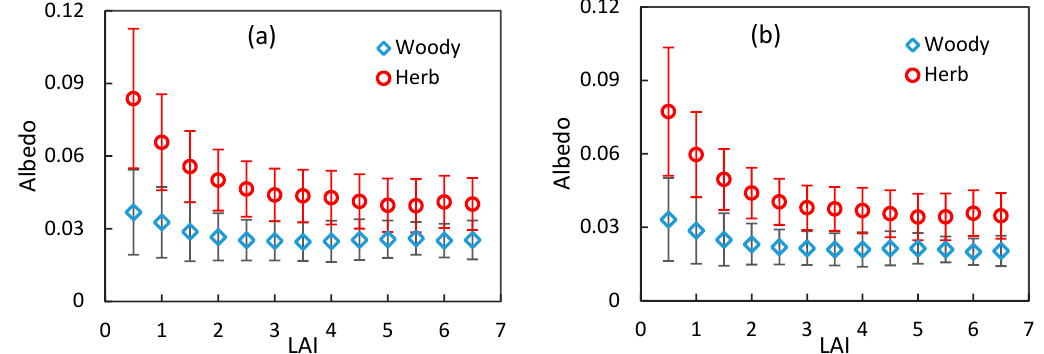
Figure 4. Variations of the white-sky ( a ) and black-sky ( b ) VIS albedo of woody vegetation and herbaceous vegetation with different LAI. The error bar is the standard